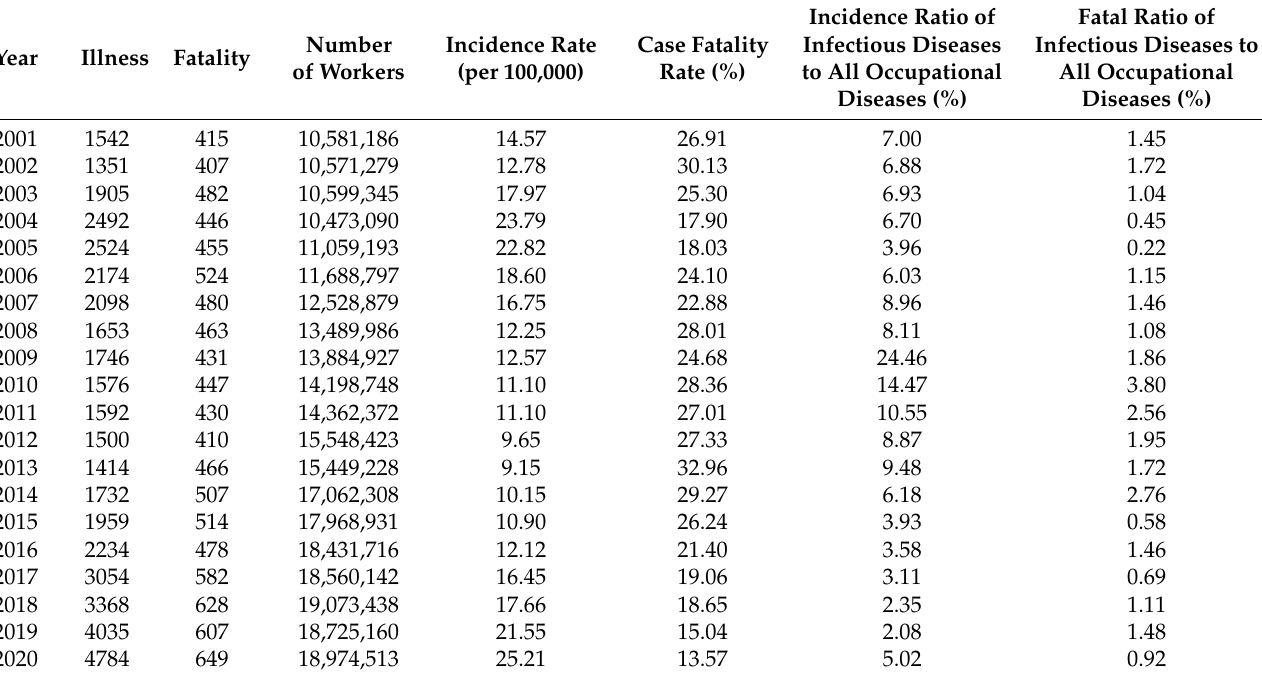
Table 4. Number, rate and change of rate of illness and fatality of whole occupational diseases and ratio of infectious diseases to whole occupational diseases by